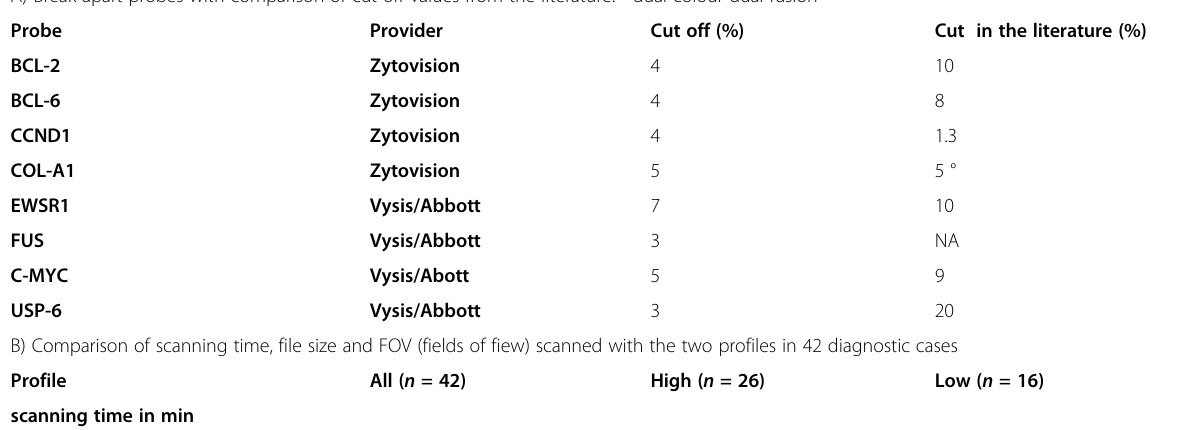
Table 1 Summaries of FISH cut-off and scanning profile A) Break apart probes with comparison of cut off values from the literature. ° dual colour dual fusion